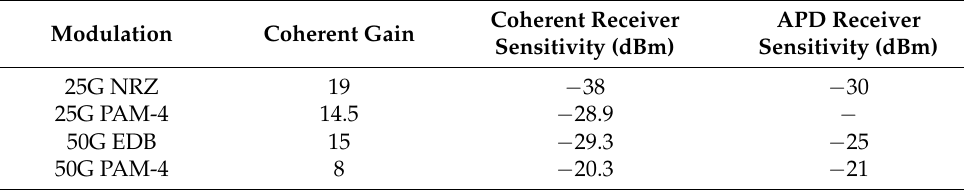
Table 11. Receiver sensitivity and the resulting coherent gain for various modulation formats for 25 and 50G. A BER value of 10 − 2 is considered [88].